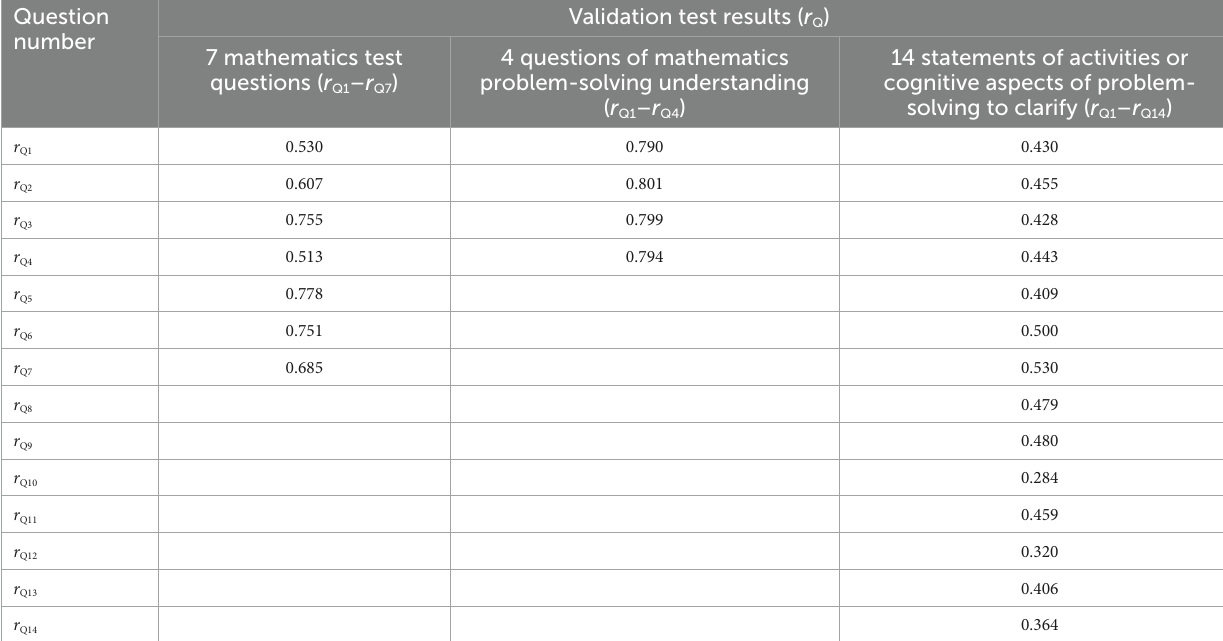
TABLE 1 Validation test results for questionnaires and